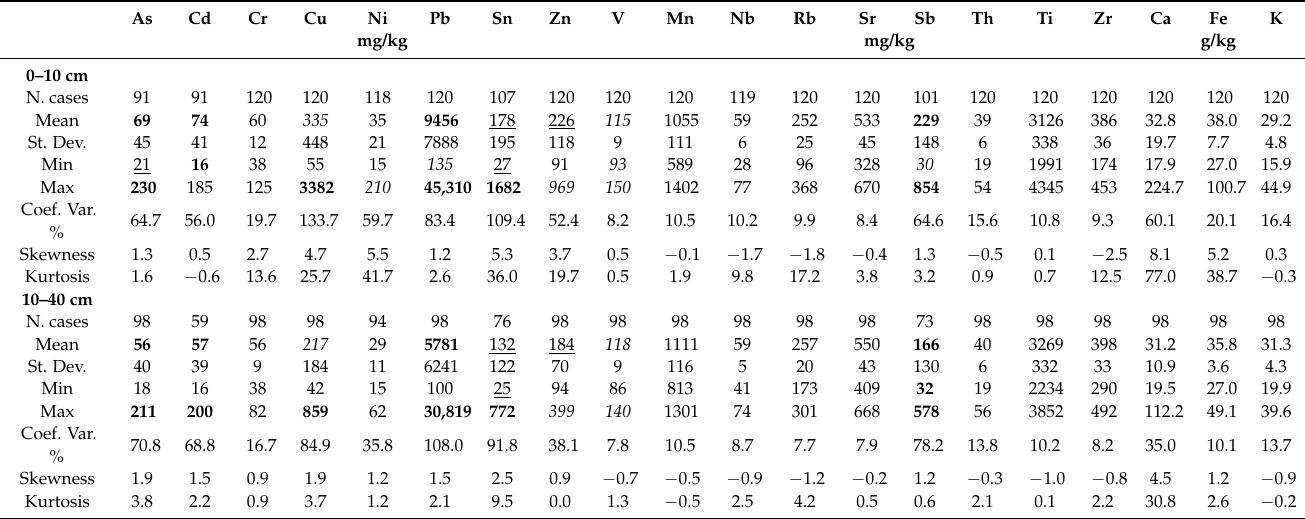
Table 5. Descriptive statistics on the content of 20 elements measured by pXRF (portable X-ray fluorescence) spectrometer at two soil depths (0–10 and 10–40 cm). Underlined: reported data exceeding CSC for residential/recreational land use (CSC1). Italics: values exceeding CSC for agricultural land use (CSC2). Bold: values exceeding CSC for commercial/industrial land use (CSC3). For As, recalculated values based on Caporale et al., 2018 were